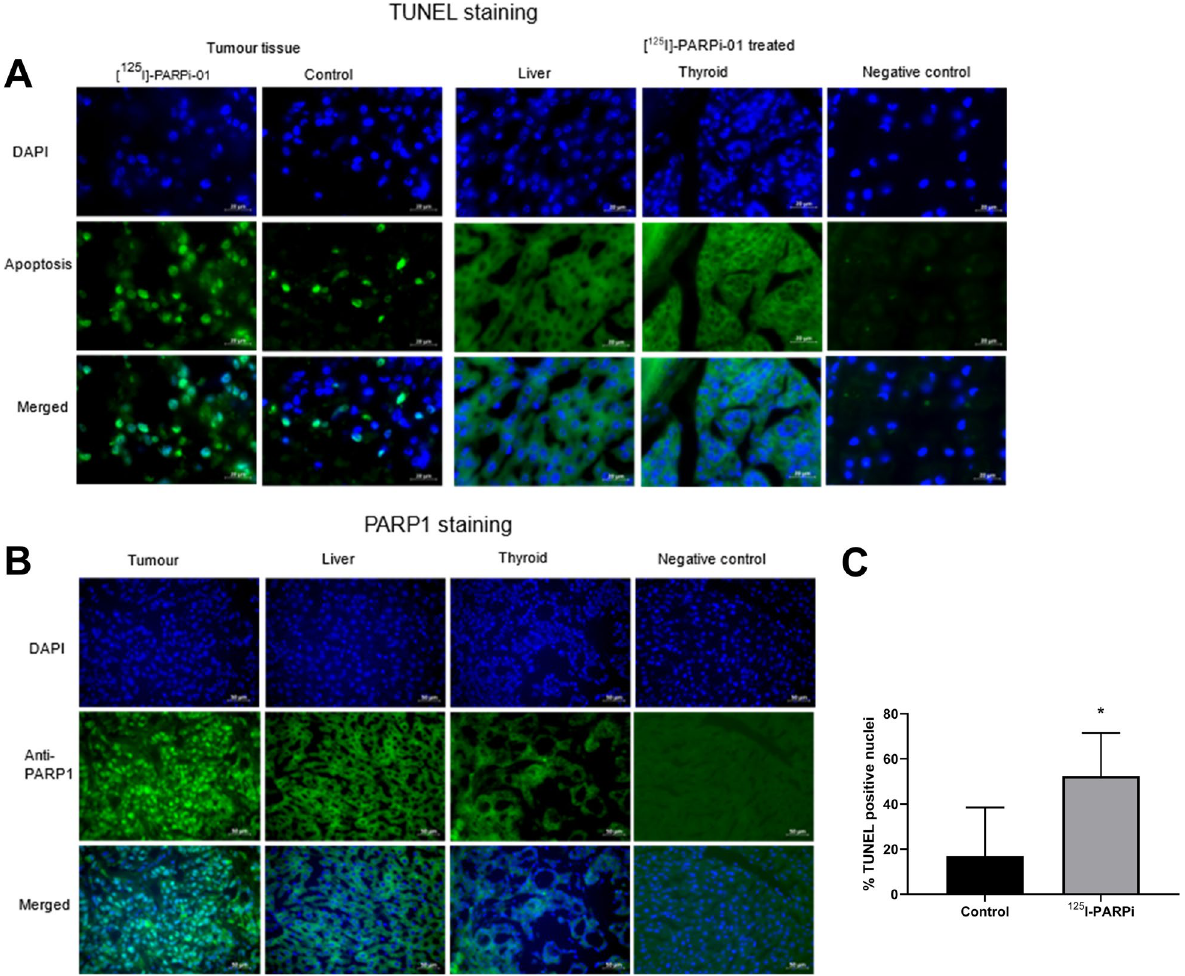
Fig. 4 A TUNEL staining of 6 µm thick tumour tissues obtained post sacrifice show high apoptosis (green) in [ 125 I]PARPi-01 treated tumour tissues as opposed to untreated tumour tissues. B Anti-PARP1 staining of target tissue (tumour) and non-target tissue (Liver and Thyroid) showed a nuclear expression of PARP1 only in tumour. Negative control without primary antibody shows no unspecific signal. C Quantification of percentage of apoptosis positive nuclei showed that [ 125 I]PARPi-01 had significantly high (unpaired t -test; p < 0.05) apoptotic nuclei than untreated tumour